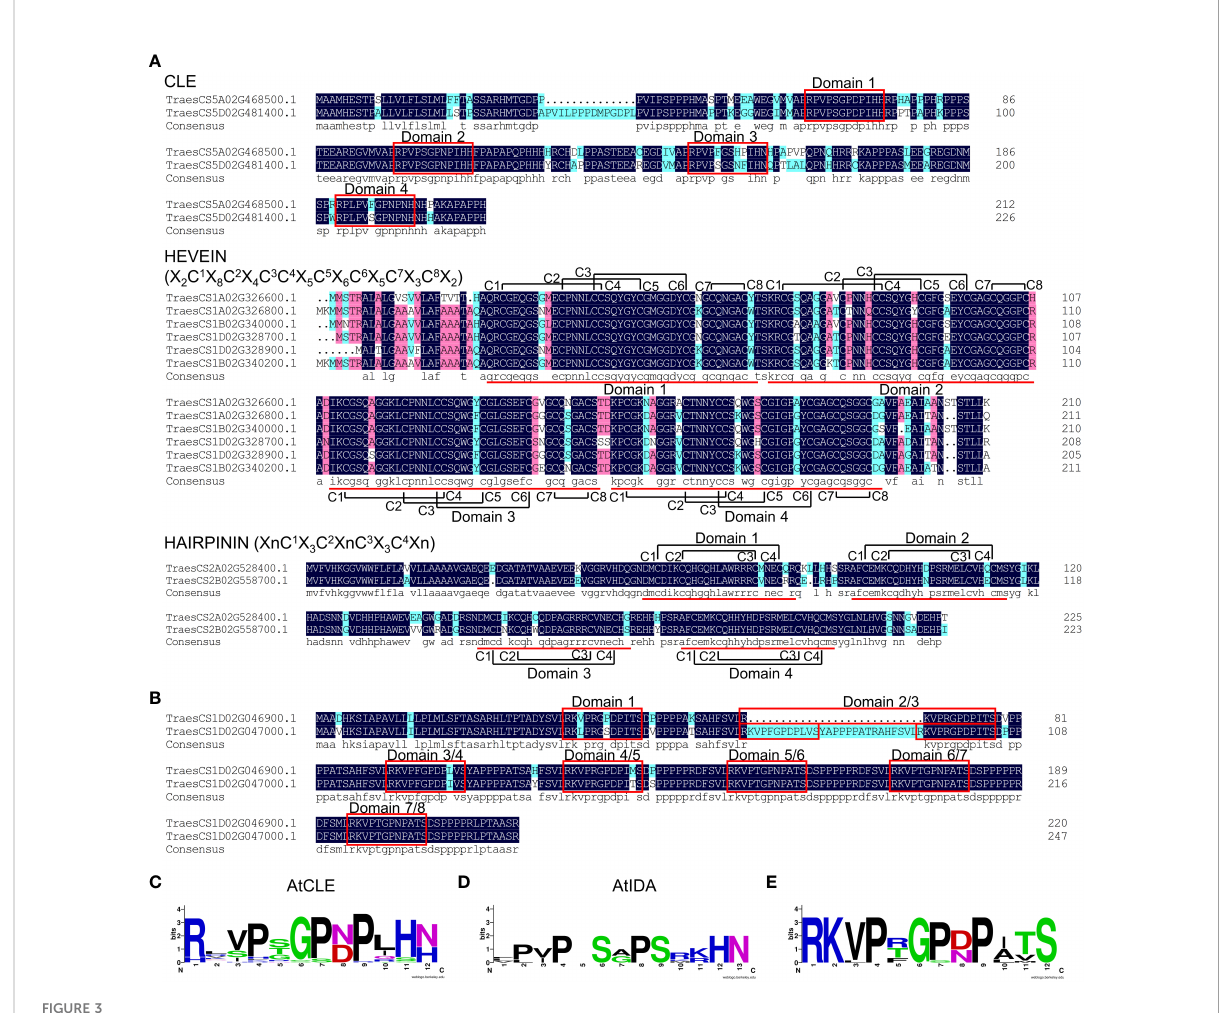
FIGURE 3 SSPs carrying multiple peptide domains in wheat. (A) Multiple sequence alignment of TaCLE, TaHEVEIN and TaHAIRPININ peptides carrying multiple SSP domains. Red boxes and lines indicate conserved SSP domains, black lines indicate the cysteines forming disul fi de bonds, the sequences within brackets indicate the sequence models of HEVEIN and HAIRPININ peptides, respectively. (B) Multiple sequence alignment of TraesCS1D02G046900.1 and TraesCS1D02G047000.1 protein. Red boxes indicate conserved SSP domains. Multiple sequence alignment was performed using DNAMAN v6.0 software. (C-E) Logos of AtCLE motifs (C) , AtIDA motifs (D) and motifs in (B) and (E) , respectively. Logos were created by WebLogo online tool